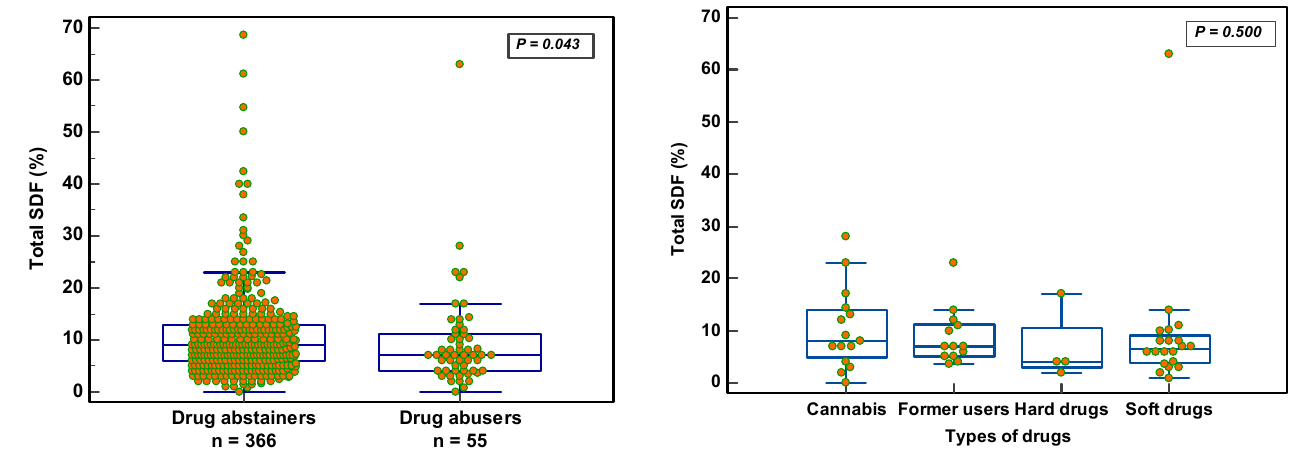
Figure 6. Effect of drug abuse and different types of drugs used on total SDF.